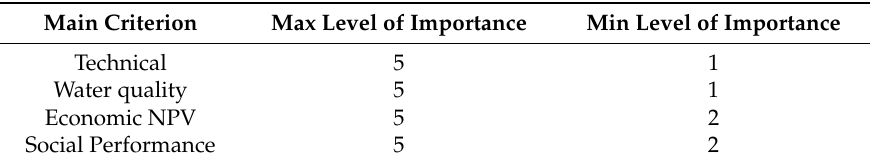
Table 14. Main criteria range of level of importance.